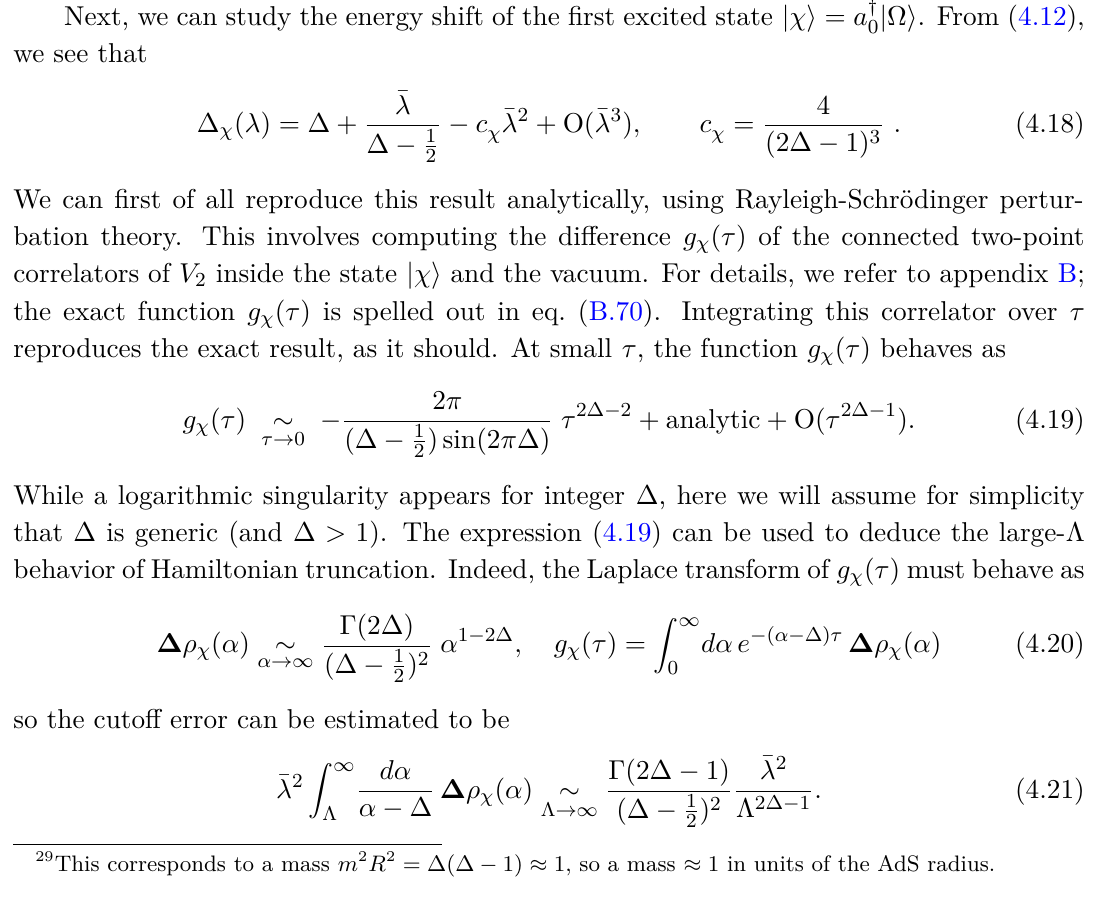
Details for the perturbative computation are given in appendix B.3. The result of both computations is shown in figure 8. For concreteness, we take the single-particle energy in the free theory to be ∆ = 1 . 62 . 29 For the nonperturbative plot on the right hand side we have set ¯ λ = 2 , beyond the radius of convergence of perturbation theory (4.13). By